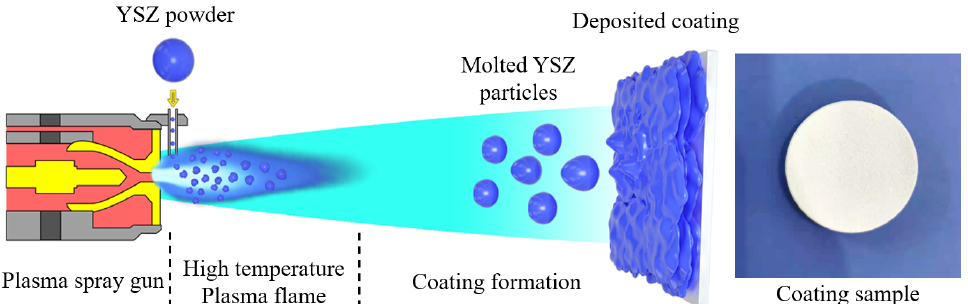
Figure 2. Schematic diagram of the YSZ coating deposited by plasma-spraying process and images of the prepared coating samples.